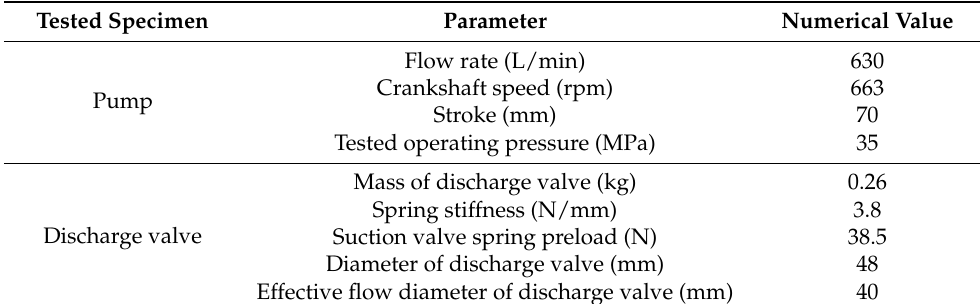
Table 1. Test pump and pump valve parameters.